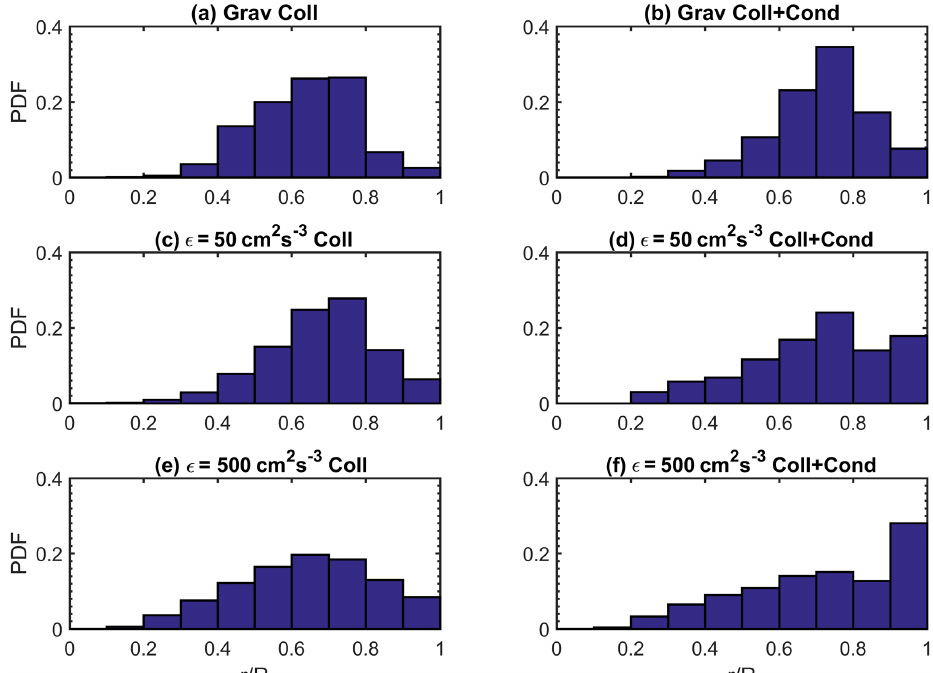
Figure 3. Probability distribution function (PDF) of collisions with respect to r/R at three different flow conditions ( a, b : pure gravity; c, d : weak turbulence; e, f : strong turbulence). Results from the collision-only experiments (a, c, e) and the condensation–collision experiments (b, d, f) are shown for